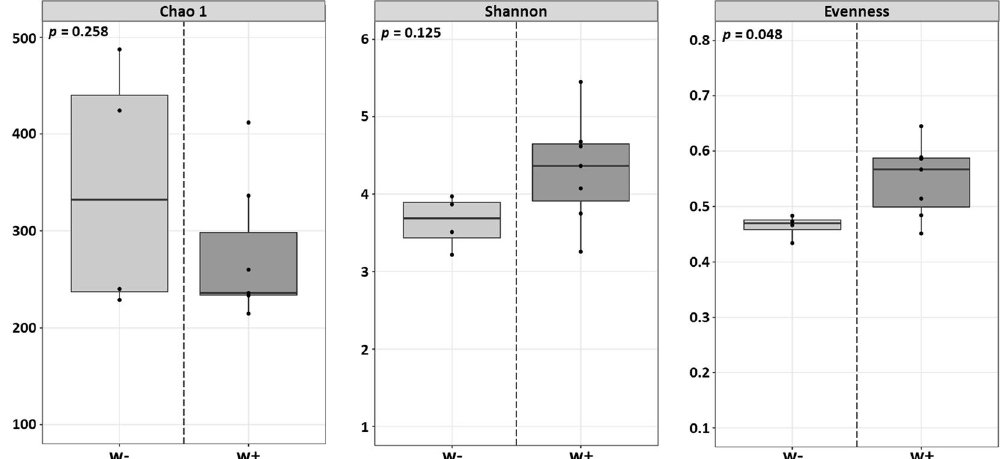
Figure 2. Impact of Wolbachia infection on bacterial taxonomic richness and diversity. Boxplots representing taxonomic richness (Chao 1), diversity (Shannon Index) and evenness. Alphadiversity indices were compared depending on Wolbachia infection (i.e. between Wolbachia -infected and uninfected isopods) using two-sample t-tests ( p -values in the top left corner of each panel). All indices were calculated at a depth of 5000 reads after merging the sequencing data from five different